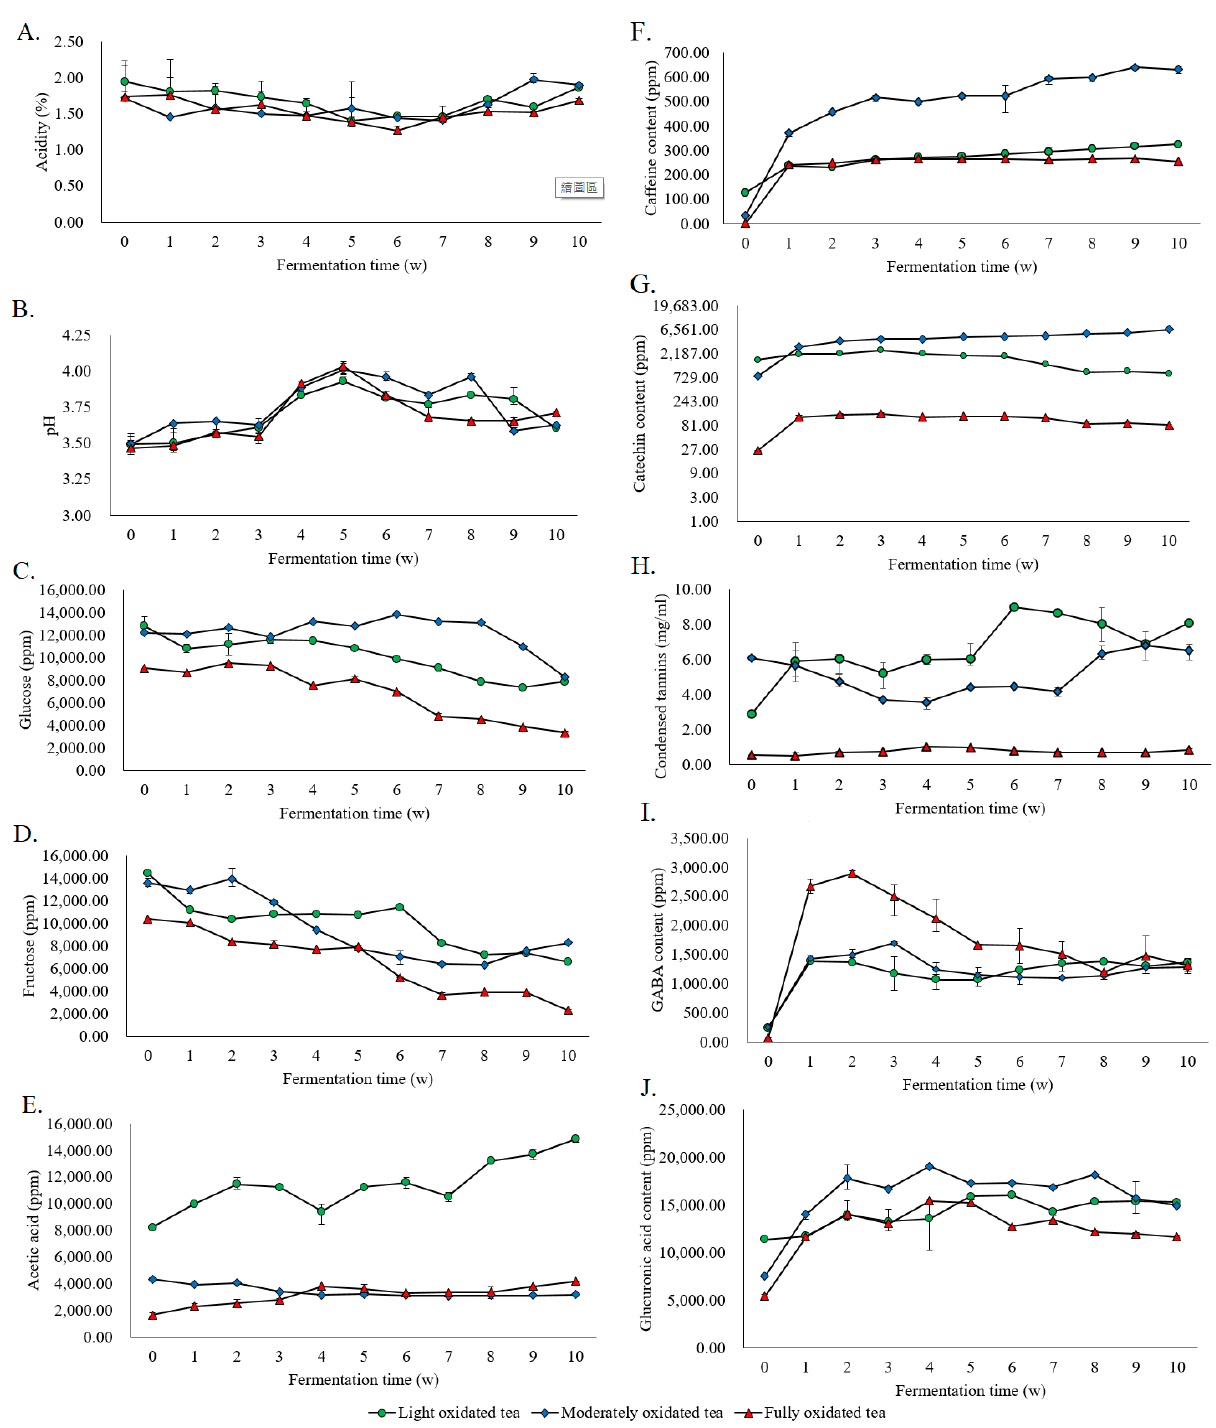
Figure 2. Changes in acidity ( A ), pH value ( B ), glucose ( C ), fructose ( D ), acetic acid ( E ), caffeine ( F ), catechin ( G ), condensed tannins ( H ), GABA ( I ) and glucuronic acid ( J ) during the fermentation process of different oxidized teas. The mean values ± standard variation of three replications indicated a significant difference at p < 0.05.